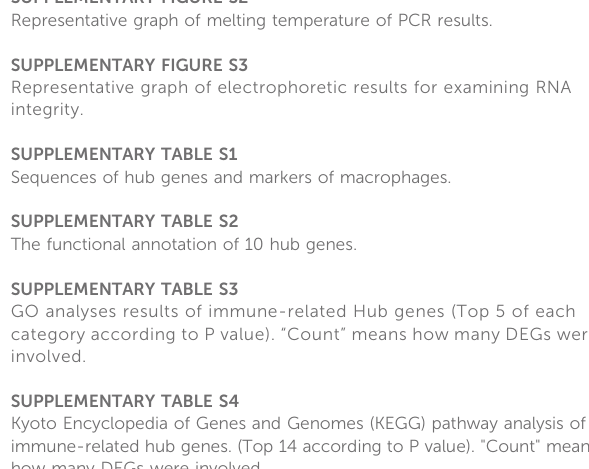
integrity. SUPPLEMENTARY TABLE S1 Sequences of hub genes and markers of macrophages. SUPPLEMENTARY TABLE S2 The functional annotation of 10 hub